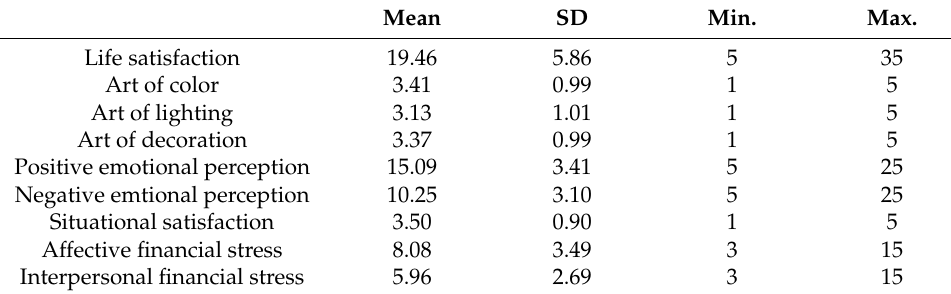
Table 1. Descriptive summary of major scales ( n = 691).